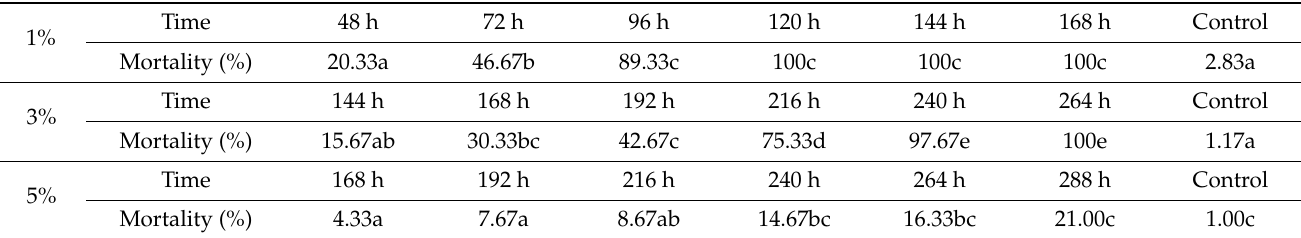
Table 1. Average mortality of S. oryzae adults exposed to 1, 3 and 5% oxygen levels at different time periods. Each treatment (combination of oxygen level and time period) had 5 samples replicated 3 times (n = 15), except for the control which had only 5 samples (n = 5). The whole set of experiments was repeated twice leading to total samples, n = 30 for each treatment and n = 10 for control. Means within rows with the same letter are not significantly different at p <